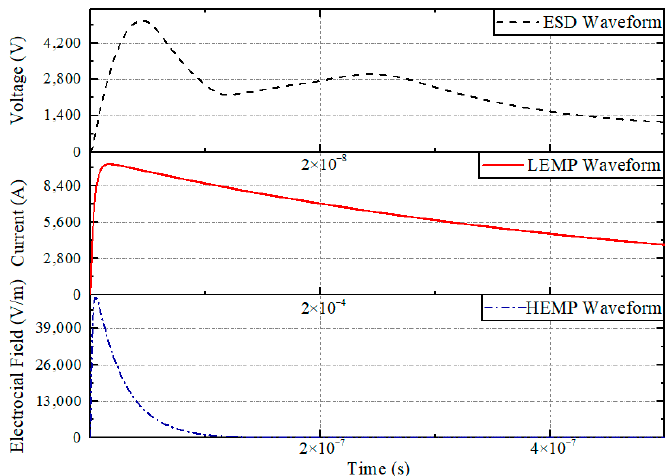
Figure 1. Familiar electromagnetic pulses.